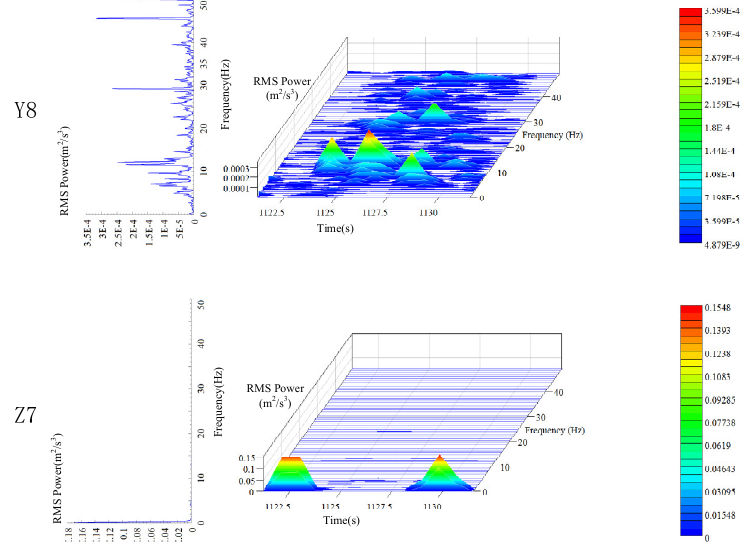
Figure 8. Time-frequency characteristics of car frame.